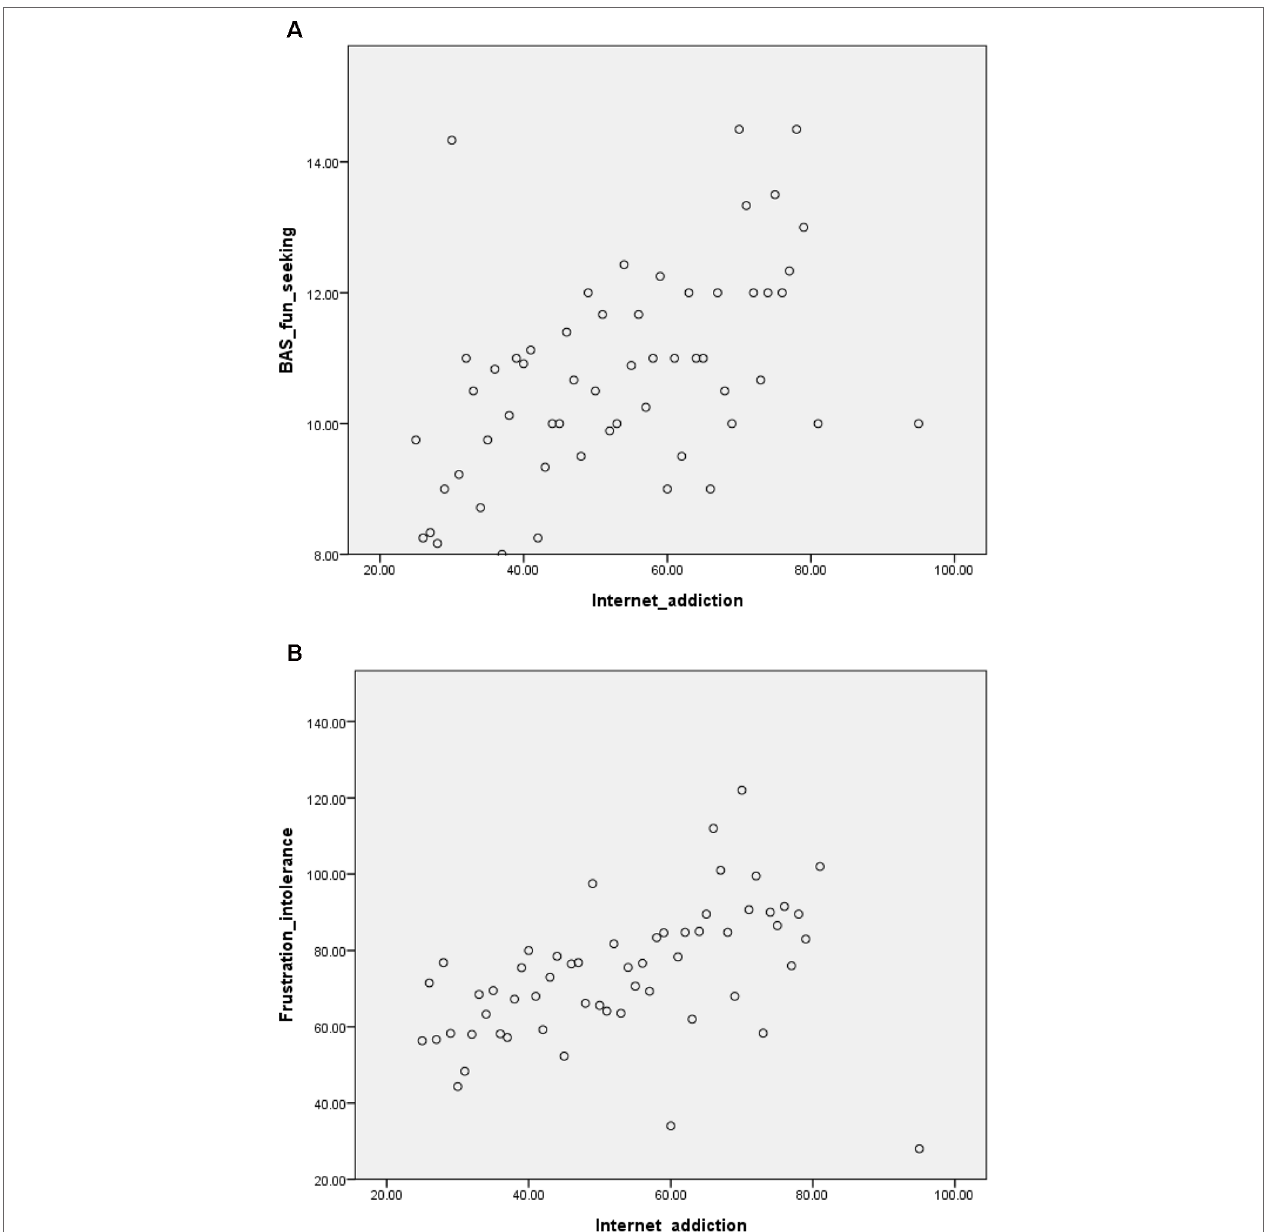
FIGURE 1 | Scatter plots of correlations between internet addiction symptoms and fun seeking on the Behavioral Approach System (BAS) scale (Figure 1A) and between internet addiction symptoms and frustration intolerance (Figure 1B)